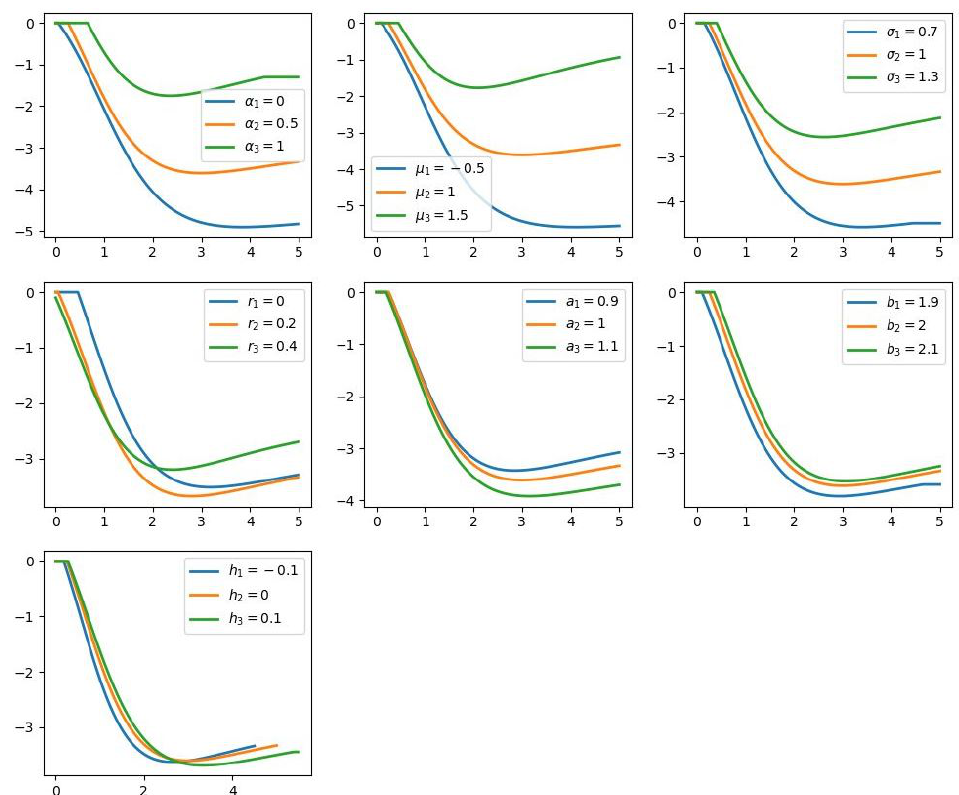
Figure 8. Sensitivity and impulse analysis of the value function of the CIR model. Each fig- ure shows the graph of the partial derivative of V ( x ) with respect to one of its parameters, for three different values of the parameter. The fixed parameters in each graph are chosen as α = 0.5, µ = 0.2, σ = 1, r = 0.1, a = 1, b = 2, h =